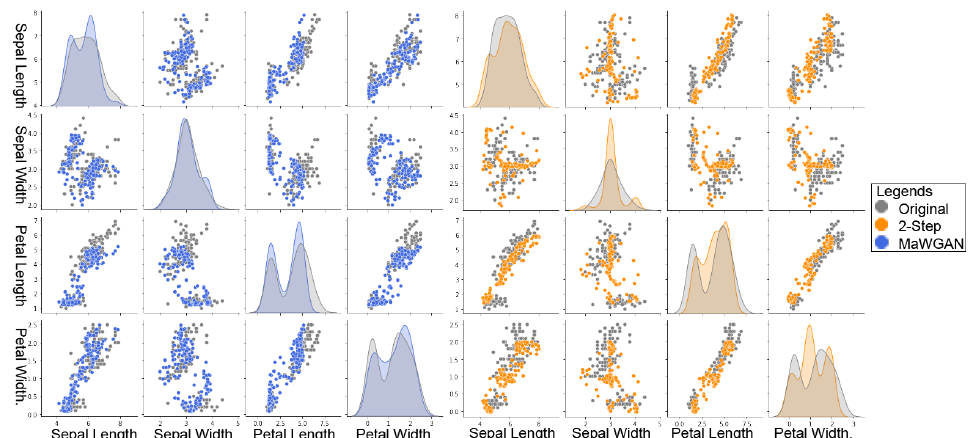
Figure 5. Original data compared with synthetic data from methods trained with 50% missing data: MaWGAN on the left and the two-step method on the right. In both cases, we overlay the original data with a synthetic sample of the same size. Marginal densities are given on the diagonals and pairs plots off the